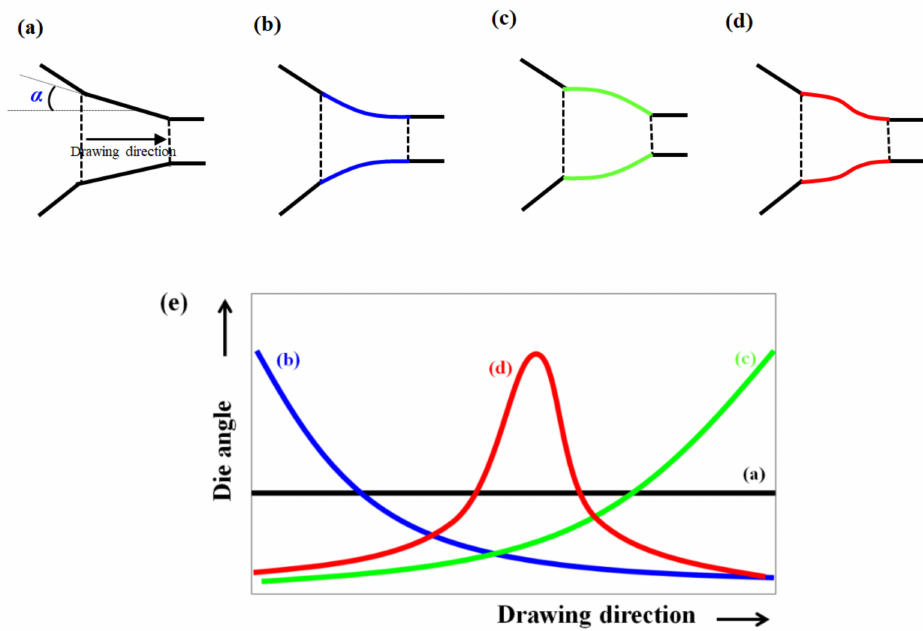
Figure 1. Schematic explanation of ( a ) the conventional die, ( b – d ) streamlined dies, and ( e ) the variations in die angle along the drawing direction during wire